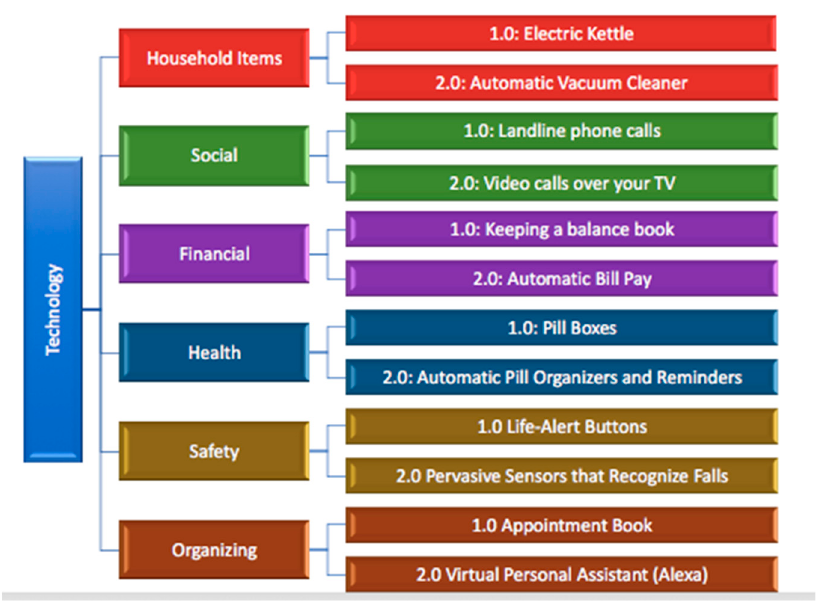
Figure A1. Technology by Domains.